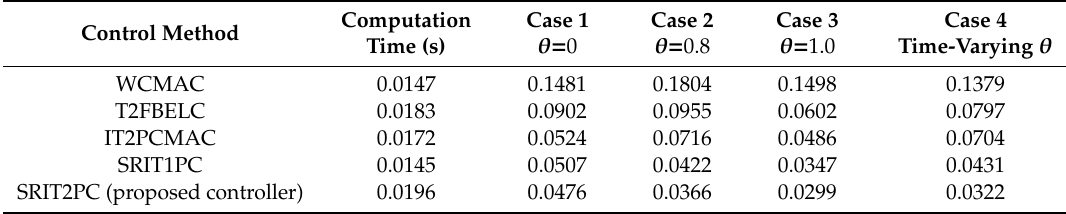
Table 1. Comparison results in root mean square error (RMSE) of synchronization the 4-D Lorenz-Stenflo chaotic system.